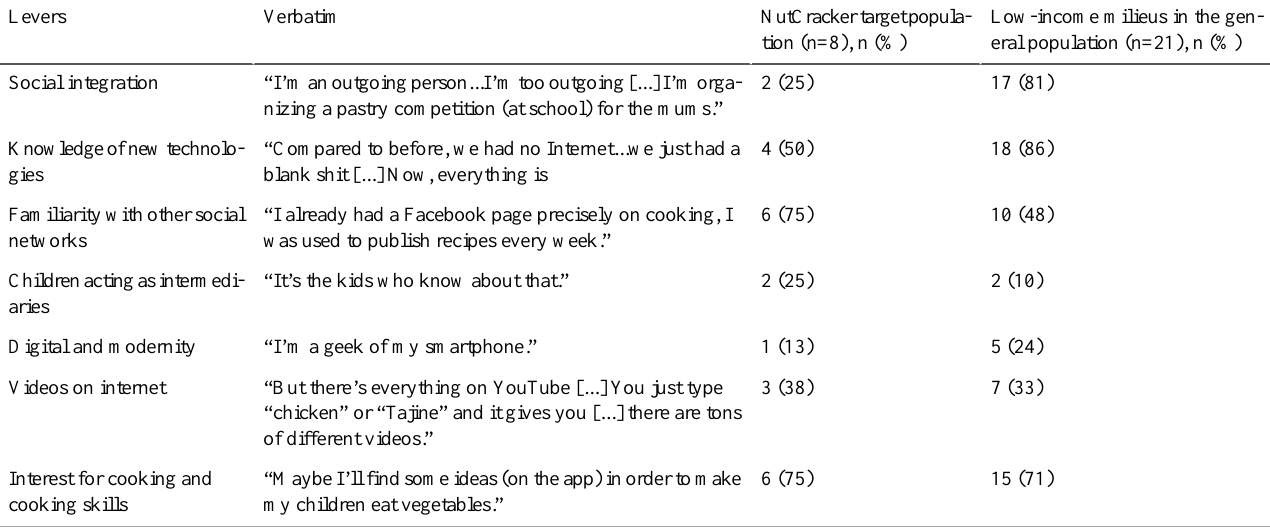
Table 4. Levers for using NutCracker and new technologies by the NutCracker sample and the low-income milieu population.